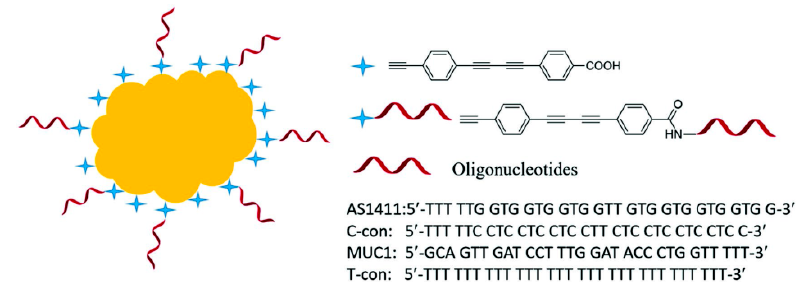
Figure 18. Schematic structure of the modified SERS nanoprobes in biologically Raman signalsilent region. Four oligonucleotides (AS1411, C-con, MUC1, and T-con) were anchored on Au NPs surface. (Reprinted with permission from Wiley, 2018 [87]).